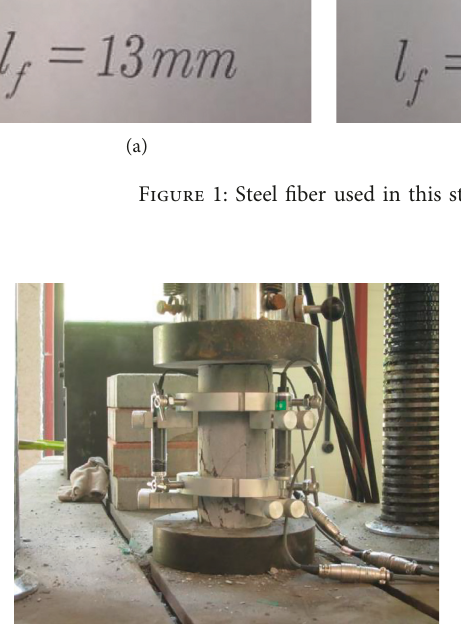
Figure 1: Steel fiber used in this study. (a) l